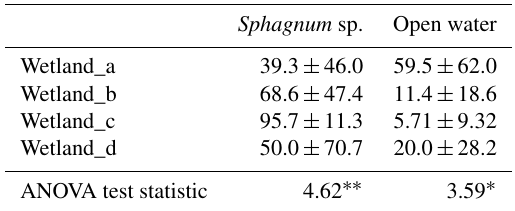
Table 2. Mean ± SD ground cover data for wetland clusters. Only variables which showed significant between cluster variability are included. Test statistic refers to the F value with ∗ and ∗∗ indicating P vales of <0.05 and <0.01,